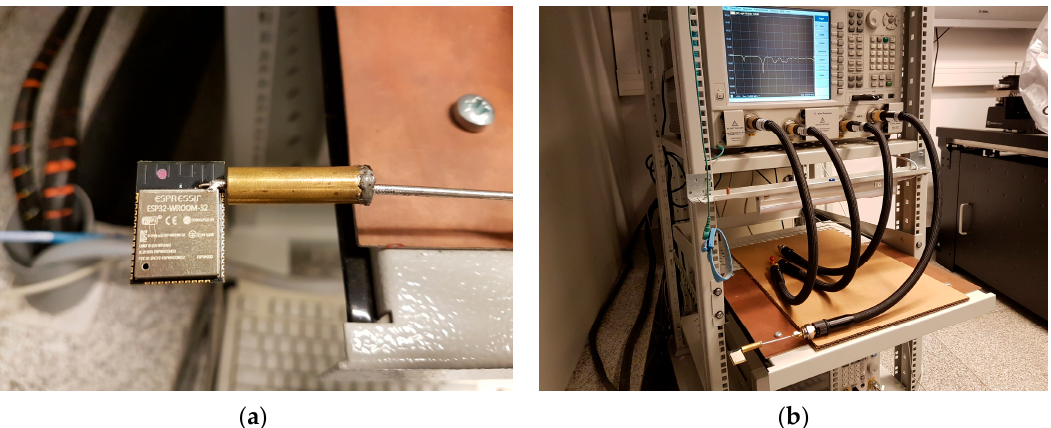
Figure 5. The laboratory measurements of the S11 parameter: ( a ) the sleeve balun choke used to suppress unwanted surface currents propagating onto the outer shield of the feeding cable and ( b ) equipment used during the S11 measurements.